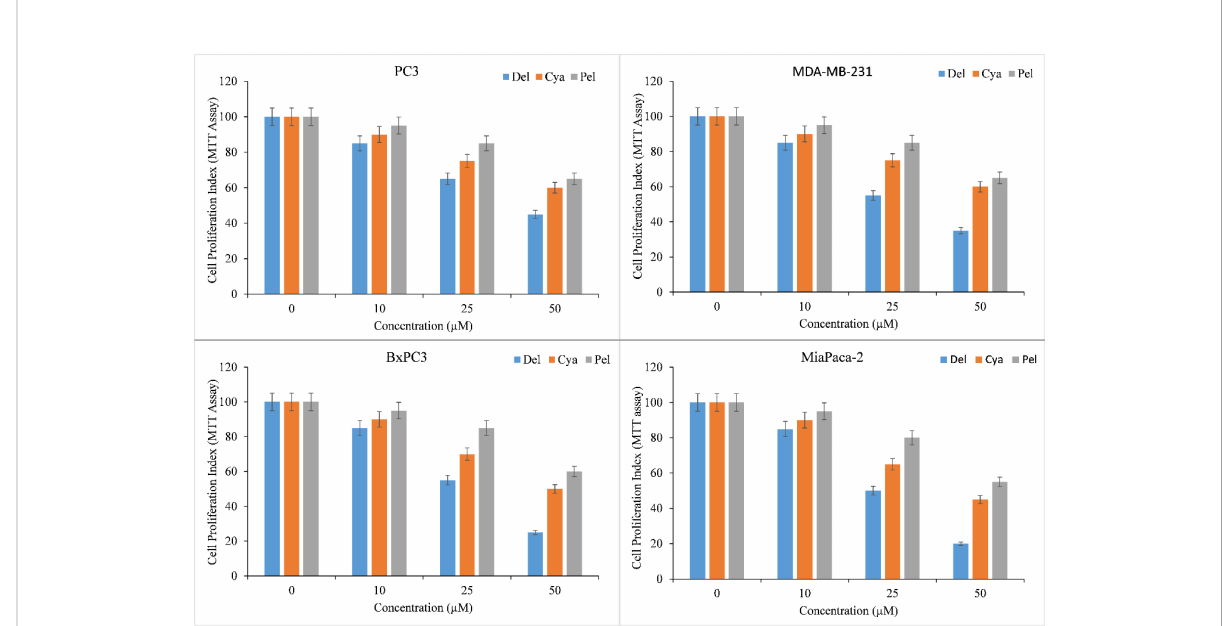
FIGURE 2 Effect of delphinidin, cyanidin and pelargonidin on cell growth in various cancer cell lines as revealed by MTT assay. Cells from PC3, MDA-MB- 231, BxPC3, MiaPaCa-2 cancer cell lines were treated with stated concentrations of anthocyanidins (mentioned above) for 72 hours. The effect on cell proliferation was measured by performing MTT test as indicated in ‘ Methods ’ . All data are expressed as percentage of control ± S.E of triplicate determinations. p ≤ 0.01 when compared to respective untreated control was treated as signi fi